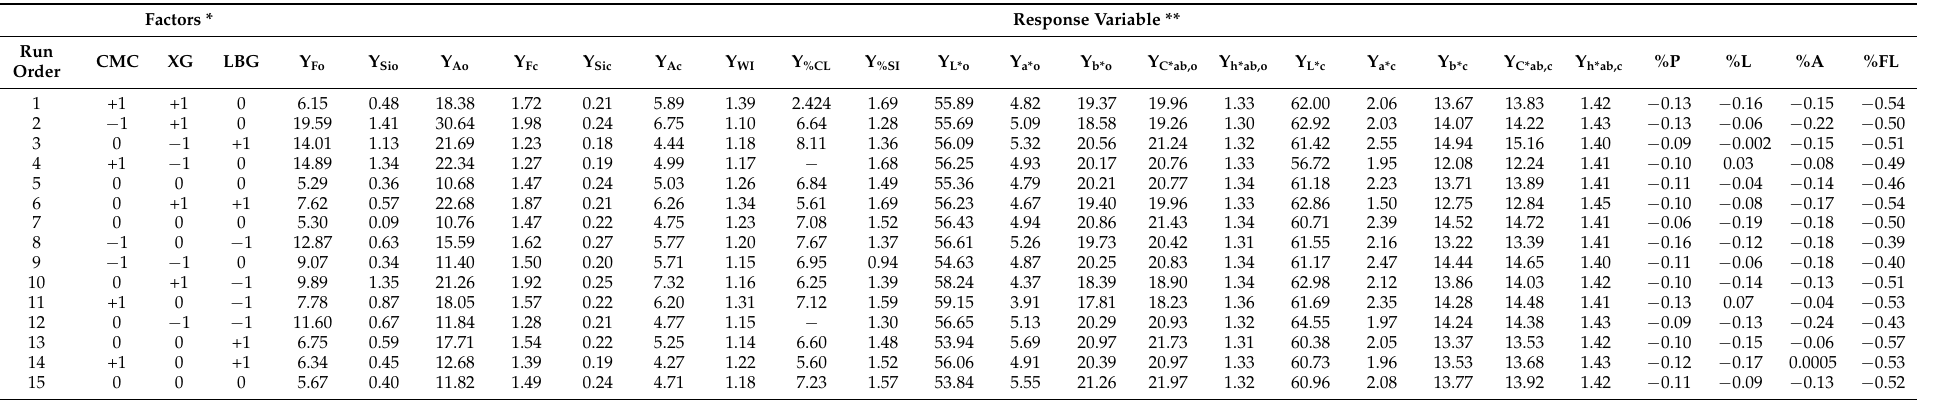
Table 2. Response variable values for the various pasta formulations that correspond to the experimental design in accordance to the levels of the three gum concentrations (CMC, carboxymethylcellulose; LBG, locust bean gum; XG, xanthan